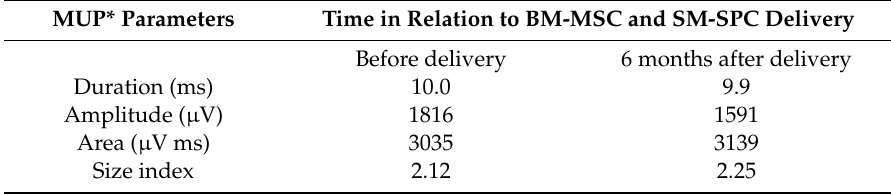
Table 4. Electromyography examination of Patient 2; MUP parameters of the biceps brachii